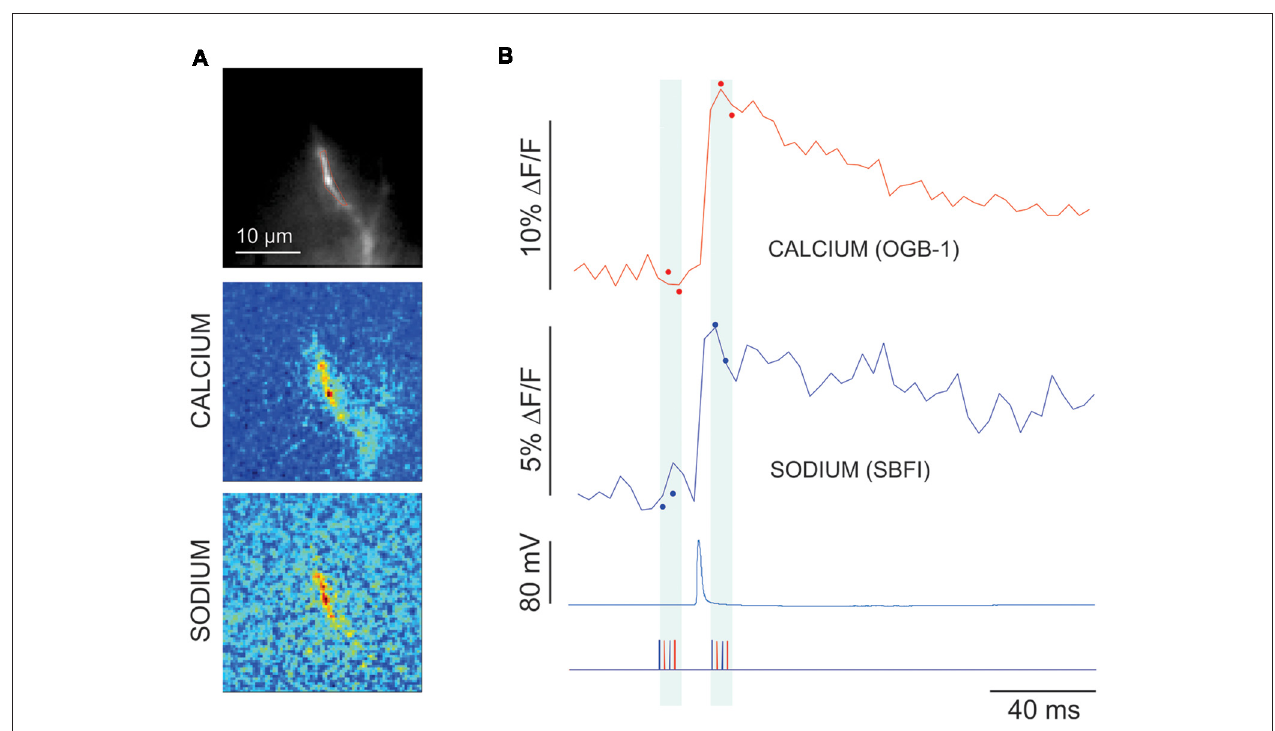
FIGURE 7 | Measurement of fluorescence signals using reduced illumination protocol. (A) Image using 60 × lens of the axon filled with 2 mM SBFI and 50 µ M OGB-1, and difference images made by only illuminating four frames (two with 377 nm laser and two with 476 nm laser) before and four frames after a single intrasomatically evoked AP. (B) Calcium (red) and sodium (blue) signals taken by limited illumination (closed circles) and full frame illumination (solid lines) from the extended ROI in the left image. Bottom trace shows timing of the light flashes of each wavelength (blue-377 nm; red-476 nm). Sodium trace and image are